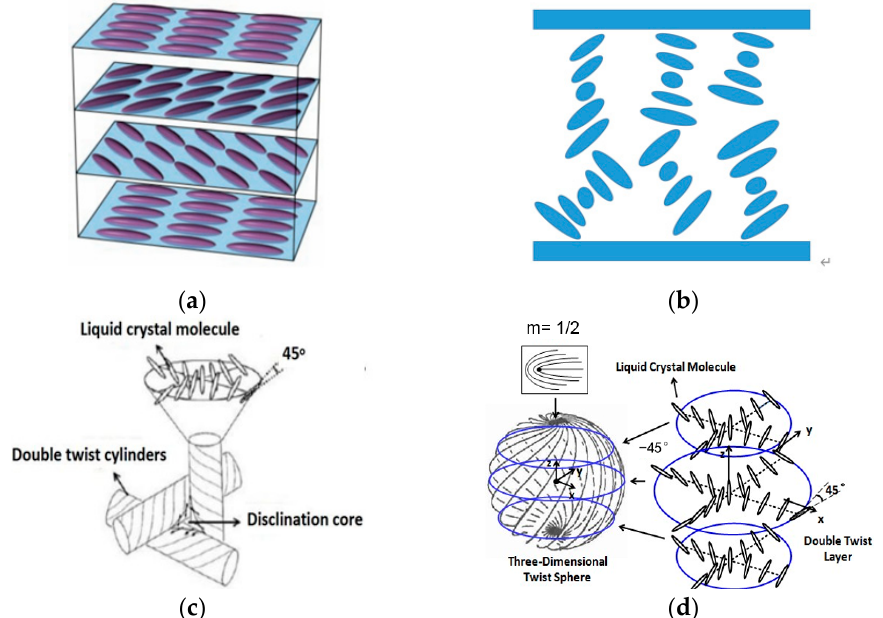
Figure 1. The arrangements of LC molecules in ( a ) planar texture state CLC; ( b ) focal conic CLC; ( c ) BPLC; ( d ) SPLC.